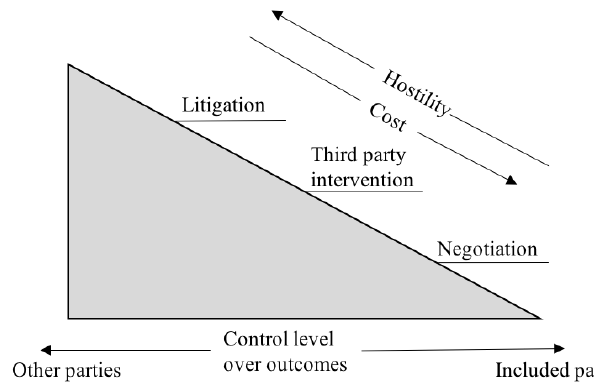
Figure 3. Potential conflicts in different stages of the entire lifecycle.